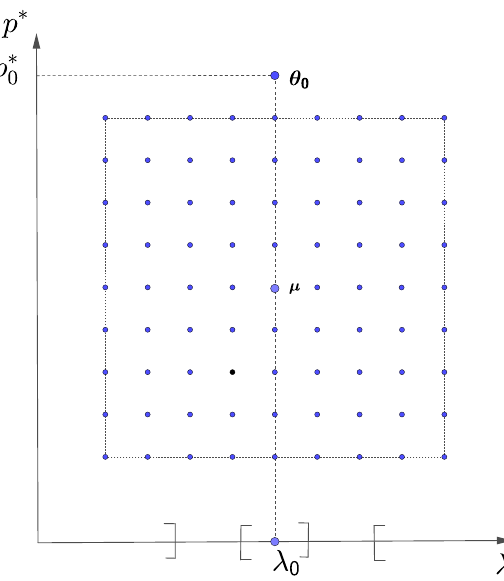
Figure 1. A square ball in the parameter